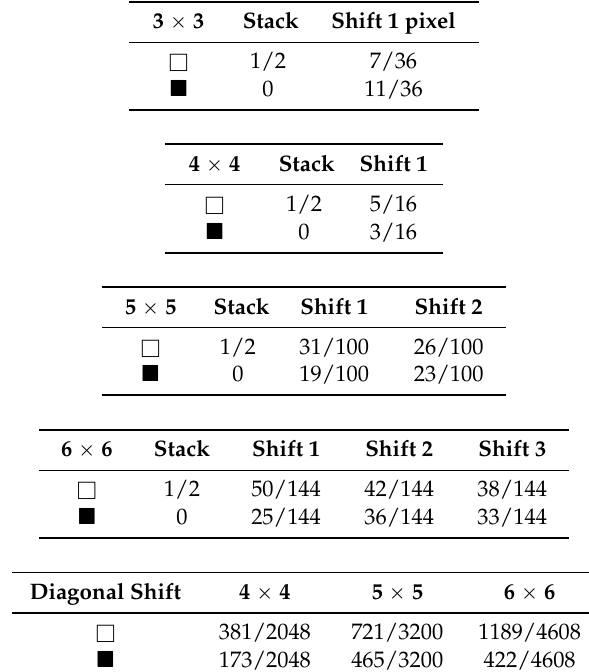
Table 9. The transmittance analysis for stacking two resulting